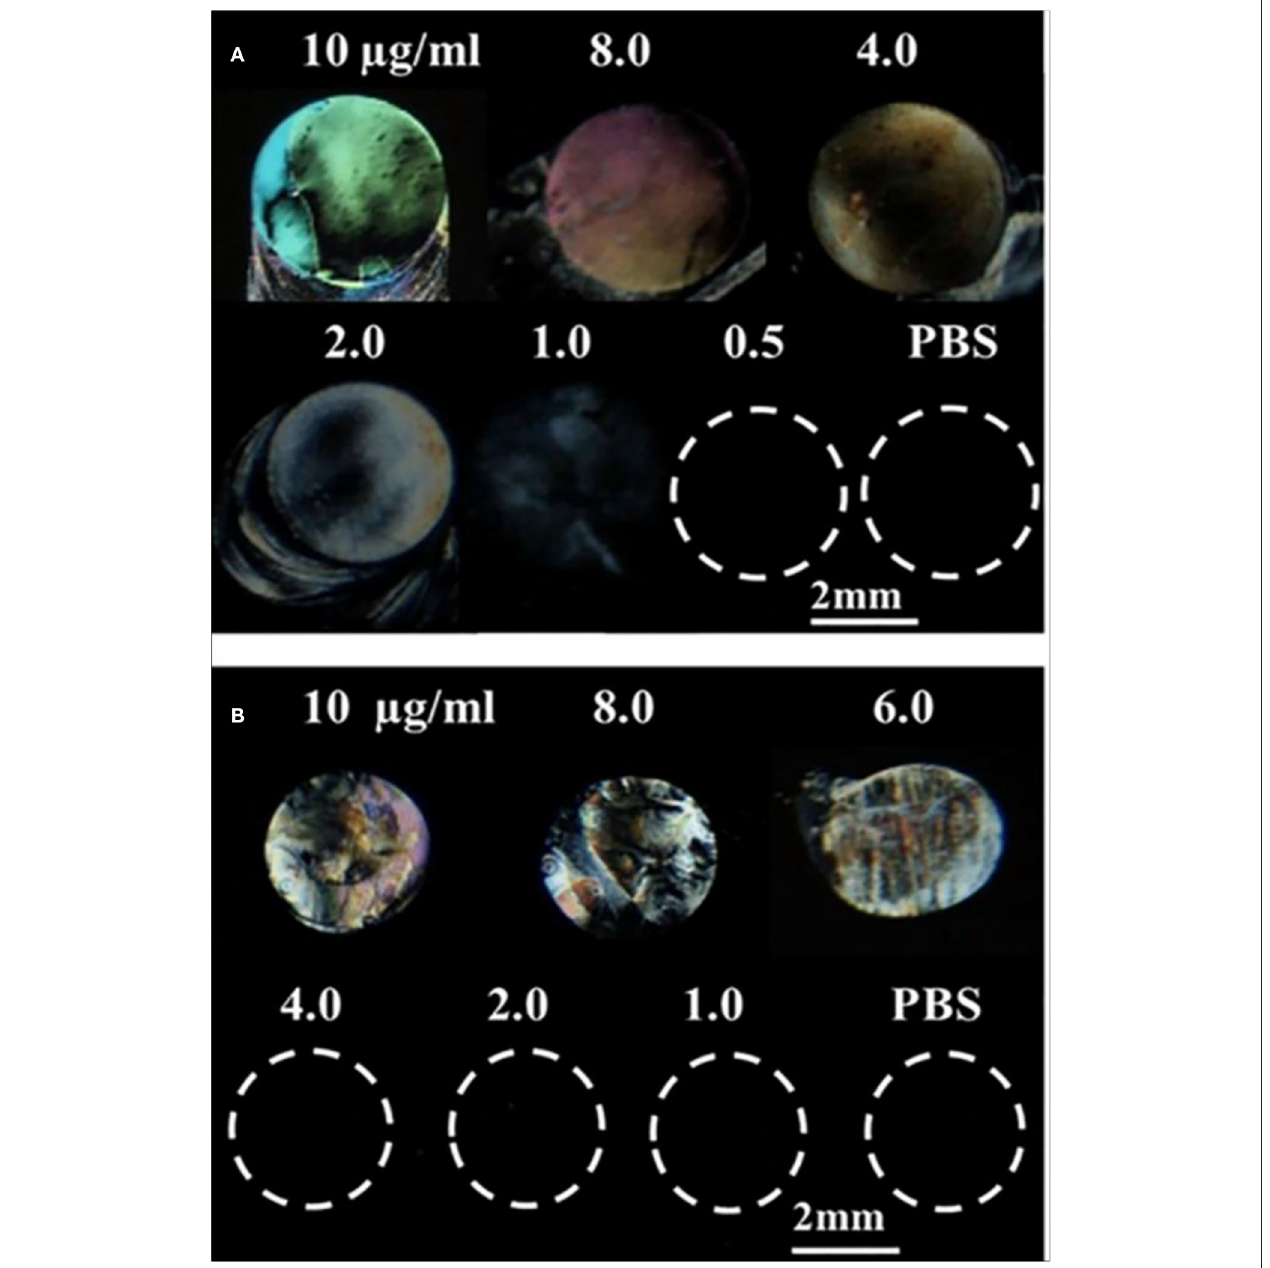
FIGURE 2 | Optical images of LCs supported on a DMOAP-coated surface immobilized with different concentrations of (A) gp-120 and (B) BSA. Number above each spot is the protein concentration ( µ